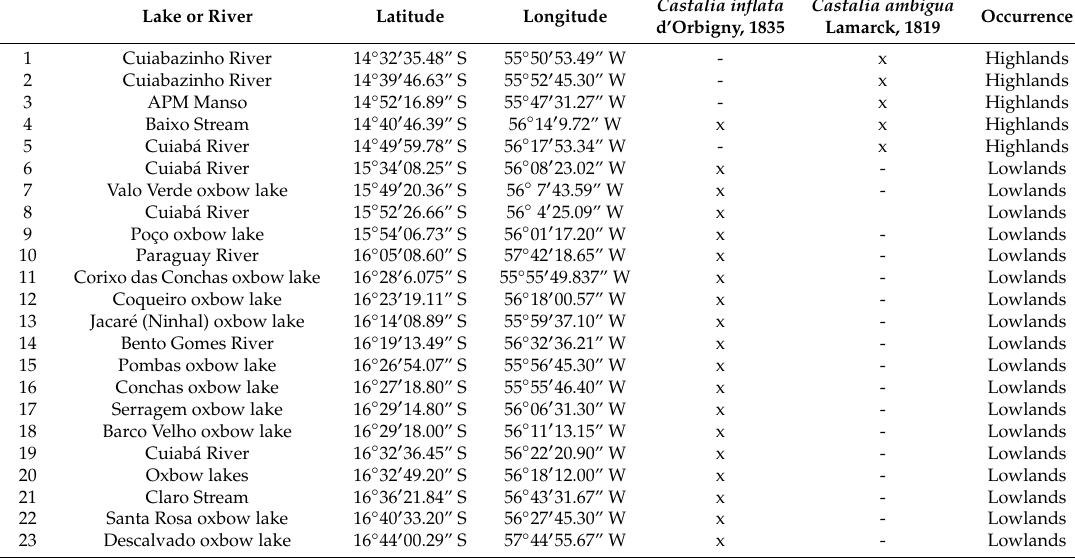
Table 1. Collection sites for Castalia specimens in the upper Paraguay river basin; “x” denotes the occurrence of specimens expressing the phenotype of that